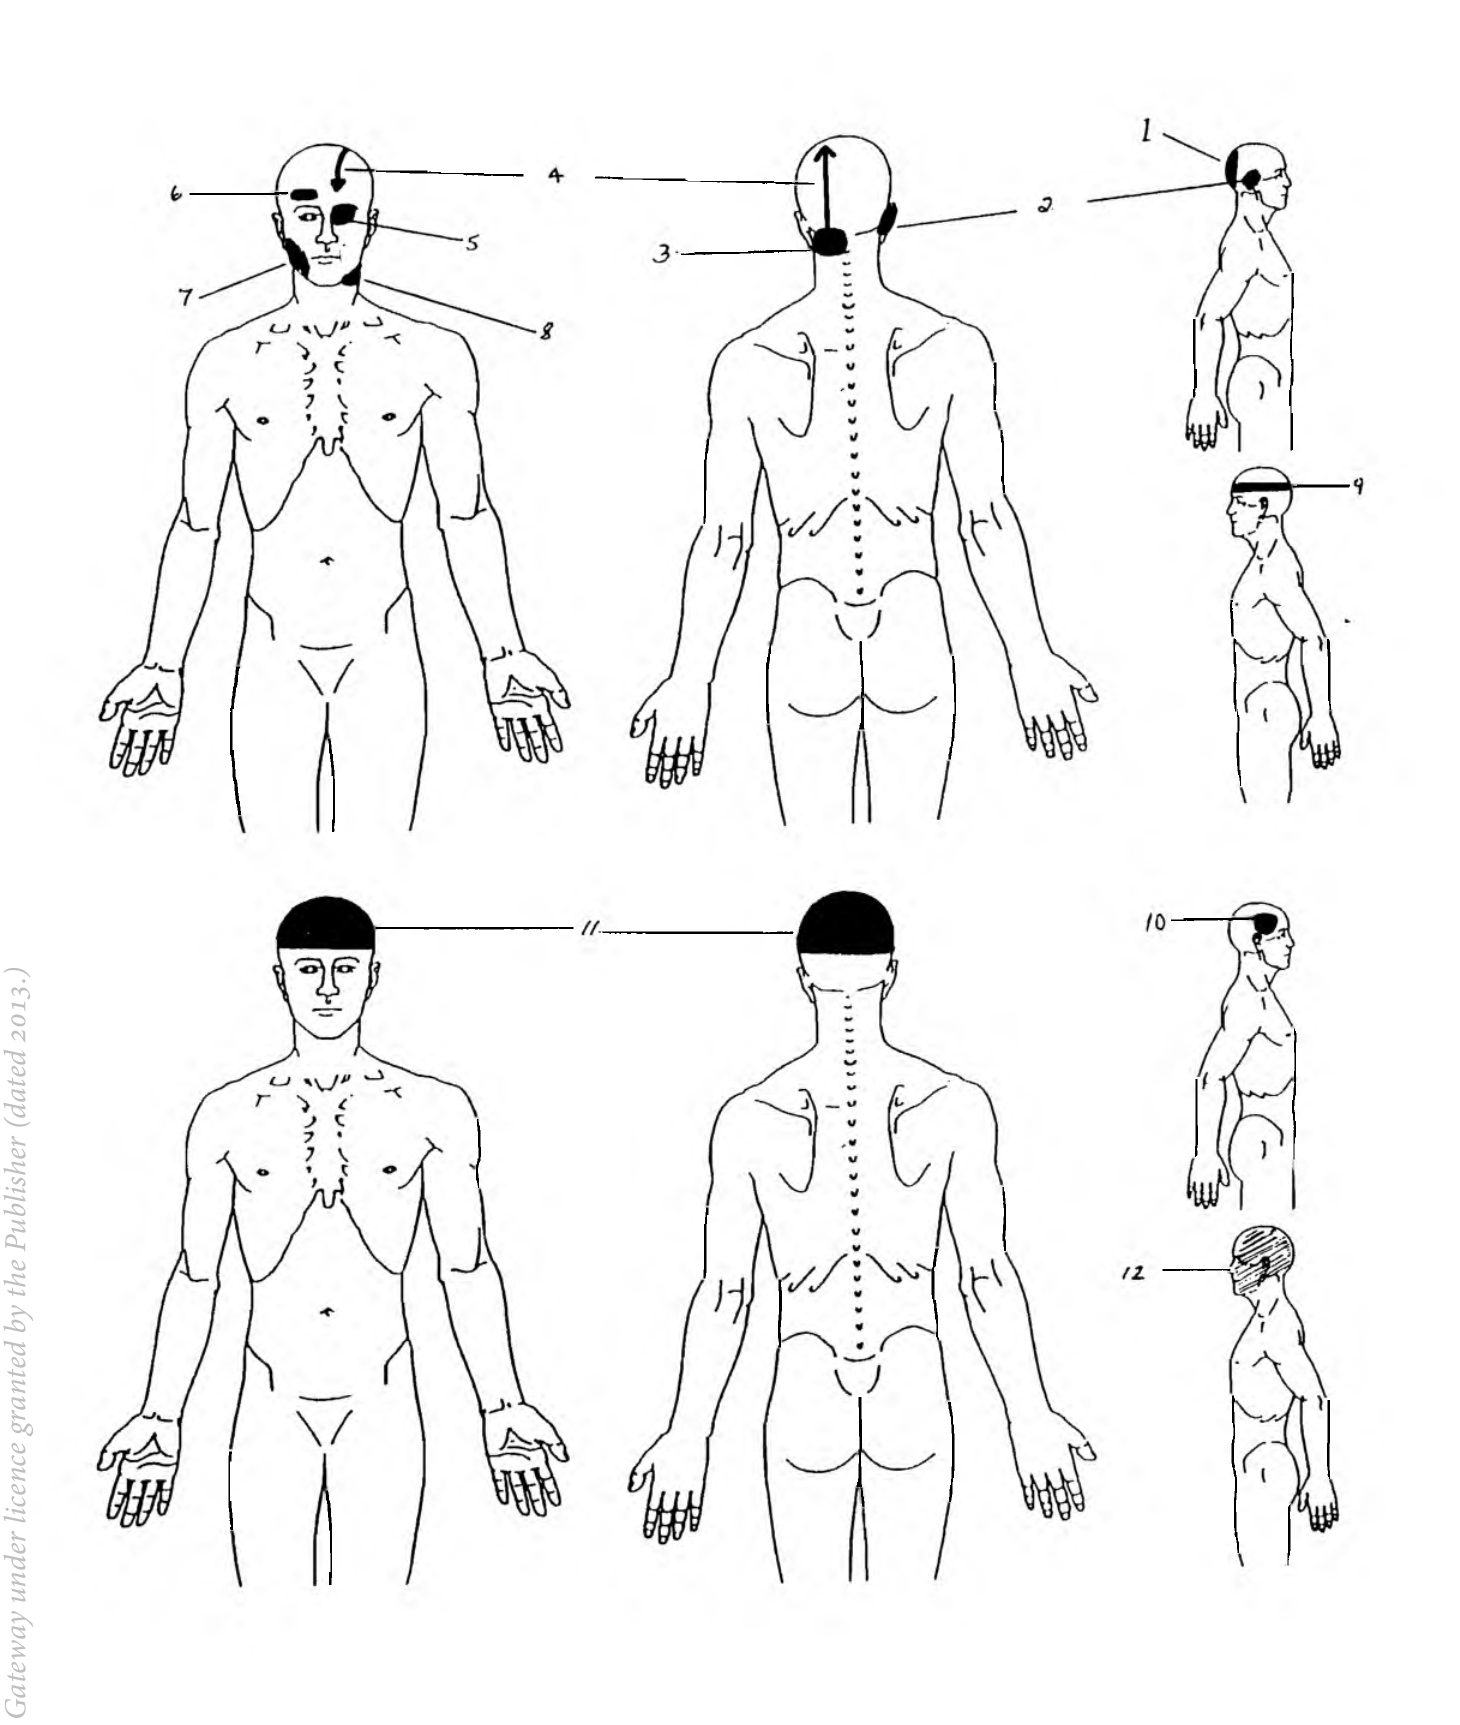
Fig 8: Cervical headache pain patterns SITE 1-CO/l, SITE 2-CO/1, SITE 3-C1/2, C2/3, SITE 4-C1/2, C2/3, SITE 5-C1/2, C2/3, SITE 6-C2/3, SITE 7-C1/2, C2/3, SITE 8-C2/3, SITE 9-C1/2, C2/3, SITE 10-C1/2, C2/3, SITE U-C5/6 Discogenic, SITE 12-T4, Lumbar (From Bang M. From Kaiser Northern California region. Teleconference: Sink or Swim-streamlining the initial evaluation,